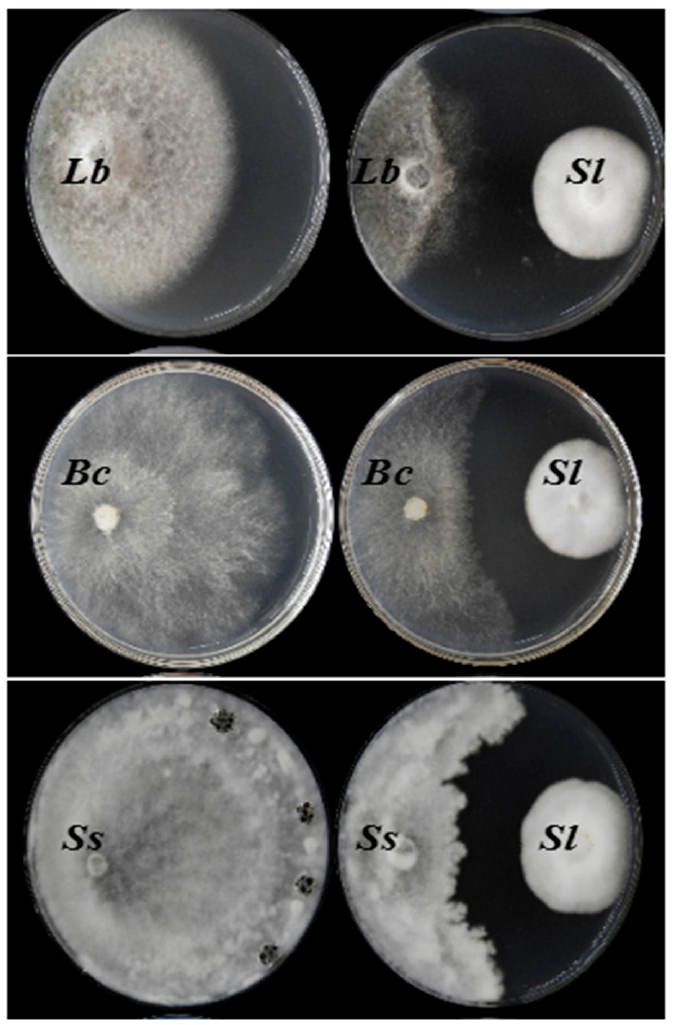
Figure 5. Dual cultures on potato dextrose agar showing the antagonistic interaction of Simplicillium lamellicola ( Sl ) JC-1 against L. biglobosa ( Lb , 20 °C, 10 d), B. cinerea ( Bc , 20 °C, 3 d) and Sclerotinia sclerotiorum ( Ss , 20 °C, 3 d).